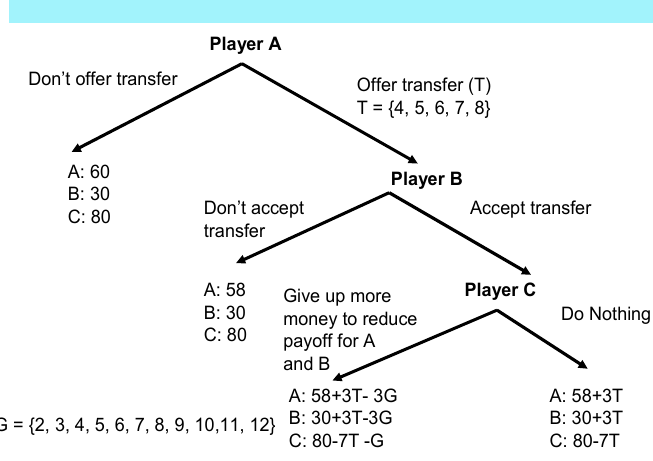
Figure 1: The Structure of the Experiment